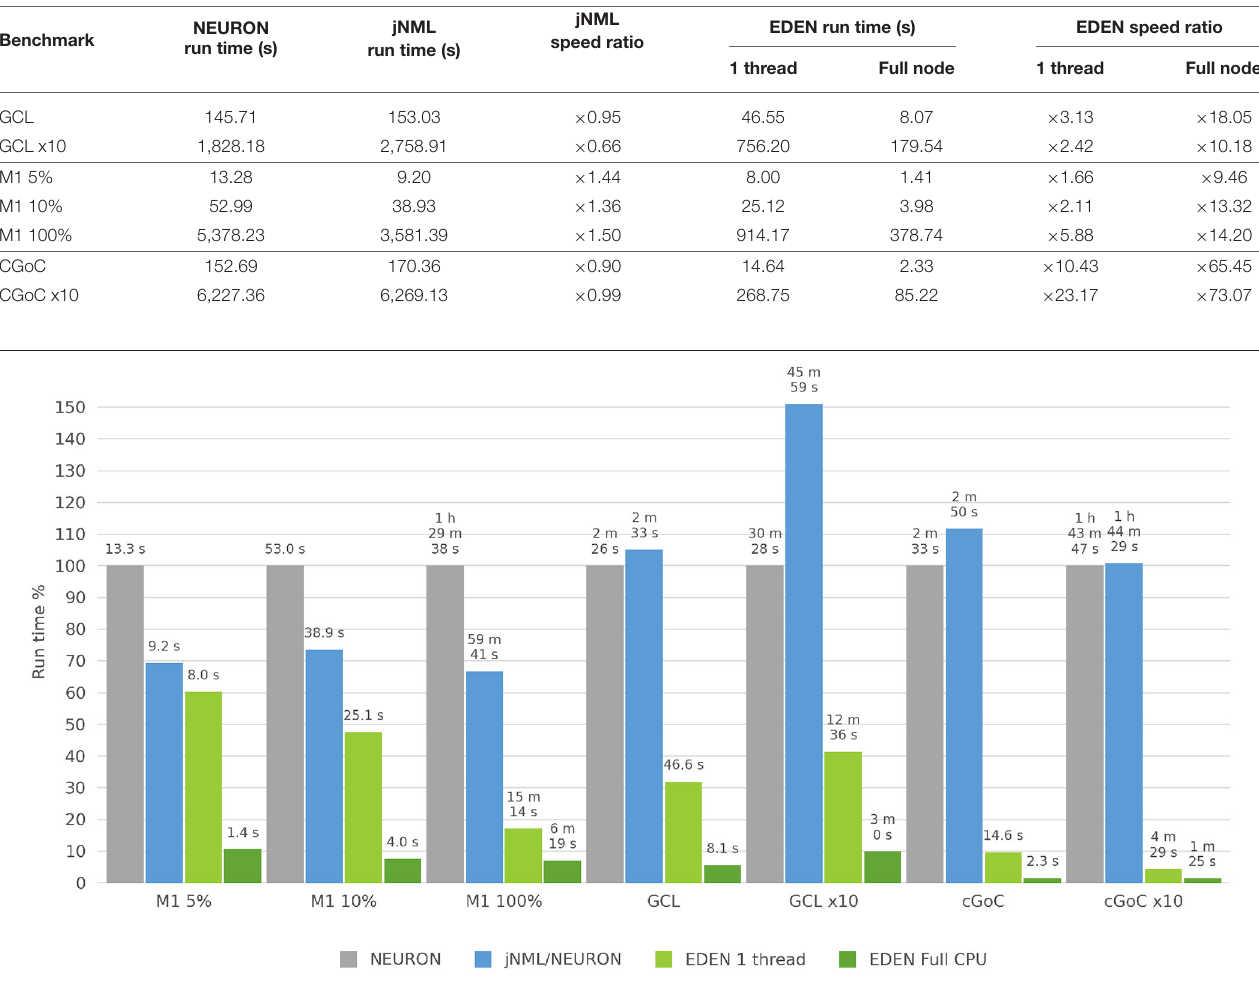
TABLE 3 | Measured run time for benchmarks for NEURON on 1 thread, jNeuroML/NEURON, EDEN on 1 thread, and EDEN using all CPU threads, and respective speedup ratios. Benchmark